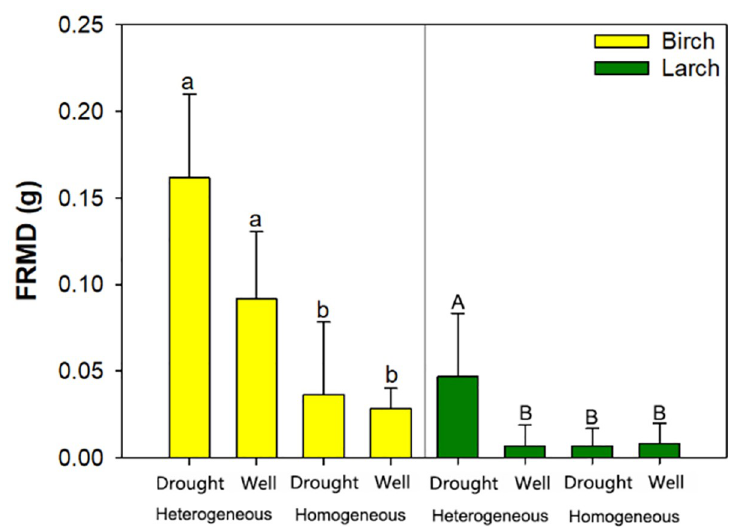
Fig 6. Fine root mass difference (FRMD) in birch ( Betula Platyphylla ) and larch ( Larix olgensis ) seedlings subjected to drought vs well-watered conditions in heterogeneous or homogeneous nutrient patterns. Bars indicate standard deviations. Different letters indicate significant difference of raw transformed data (see S1 Table) according to Duncan test at 0.05 level. Lower case letters stand for differences for birch seedlings and capital letters for larch